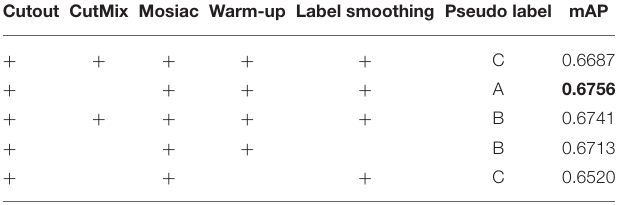
TABLE 5 | Ablation experiment results on our